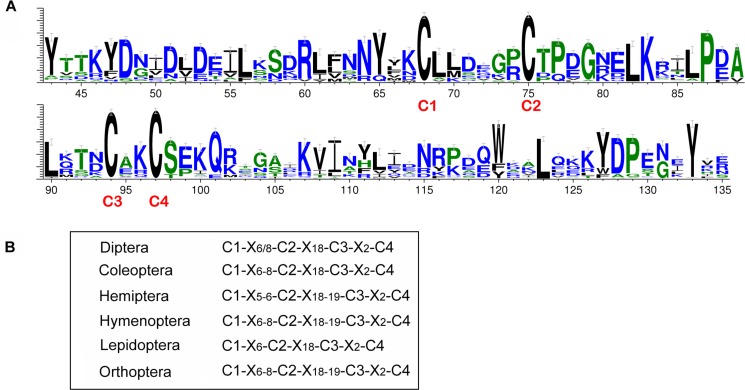
Conserved amino acid sequences and domains of the CSP family.A) The conserved aa sequences with frequency of aa occurrence for the 22 mosquito genomes. B) The conserved four cysteines domain (C1-C4) in different orders of insects. X6/8 indicates 6 or 8 non-cysteine aa; X18 is 18 aa; X6-8 is 6–8 aa.